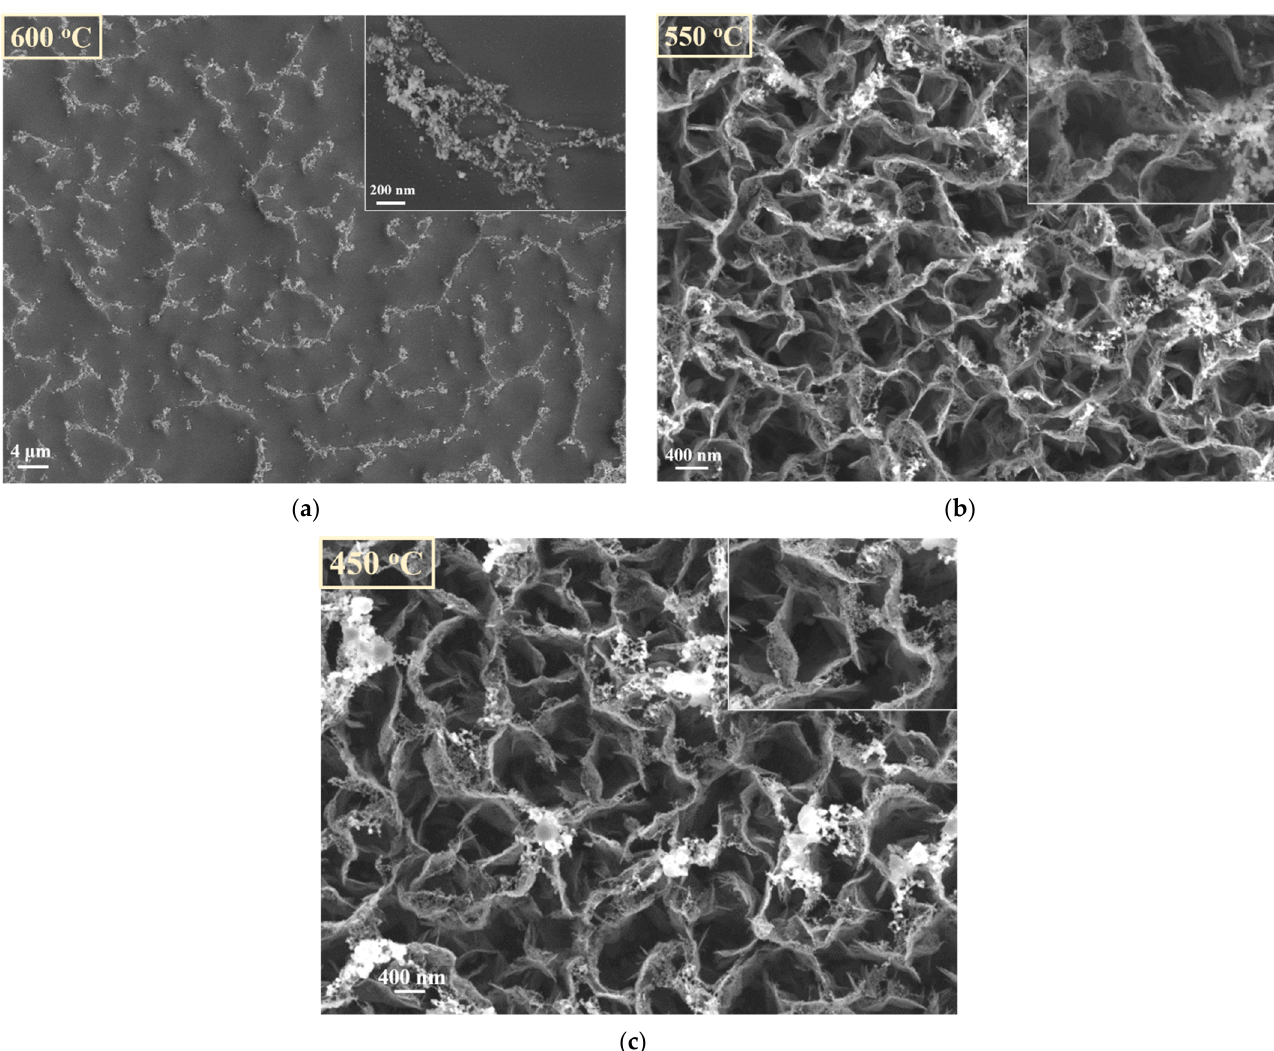
Figure 12. CNW template after thermal treatment in presence of plasma, at different temperatures ( a )—the first position corresponding at 600 °C; ( b )—the second position corresponding at 550 °C; ( c )—the third position corresponding at 450 °C)